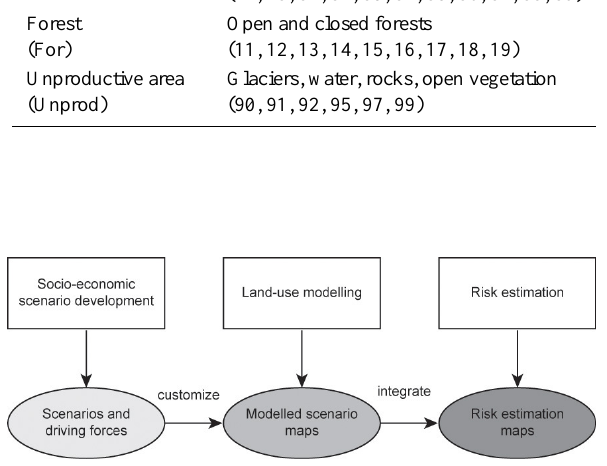
Figure 1. (a) Location of the risk study area in Naters, Switzer- land and of modelled overdeepenings in the glacier beds in the Aletsch Glacier area, which are assumed potential sites of future lake formation (Linsbauer et al., 2013). Integration of the inten- sity maps elaborated for the outburst scenarios of 4millionm 3 (b) , and 20millionm 3 (c) . DEM25 reproduced with permission of Swis- stopo (BA110005).